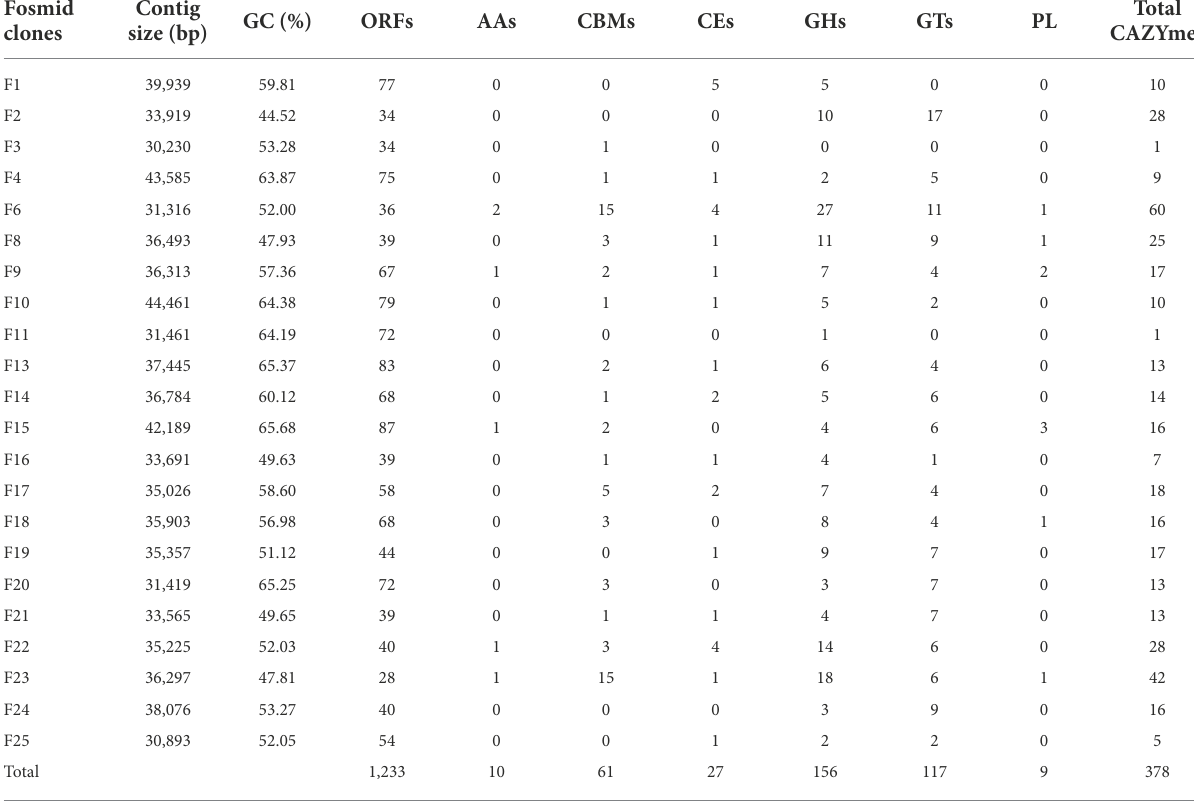
TABLE 3 The DNA Insert size of each fosmid in base pairs, the number of ORFs, and detected CAZyme classes. Fosmid